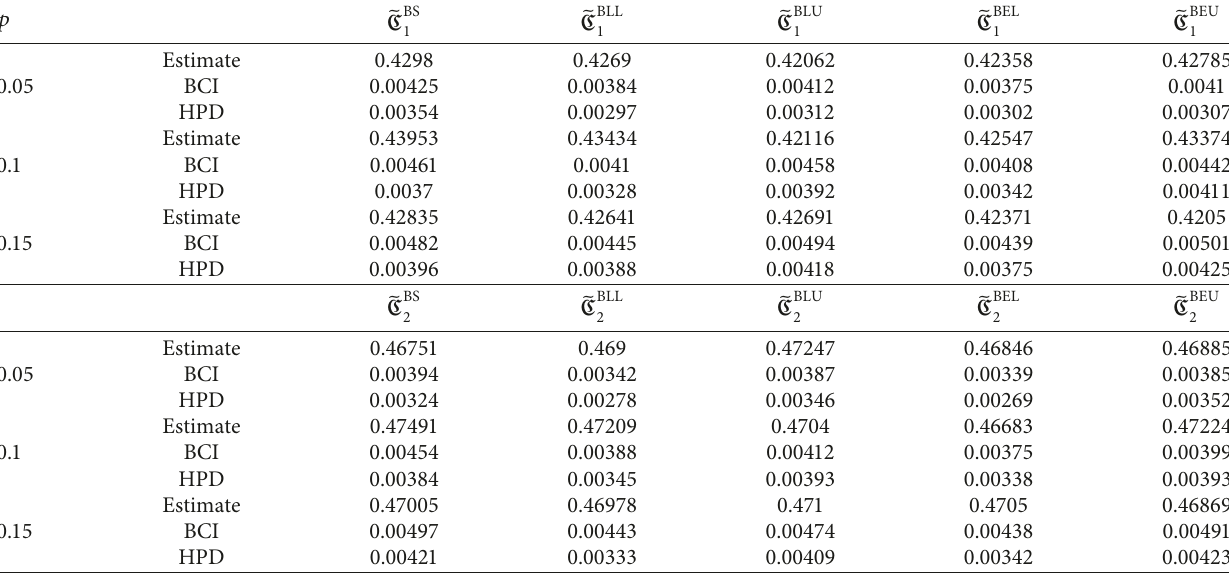
and C with their lengths of CI for different m for n and p 1 2